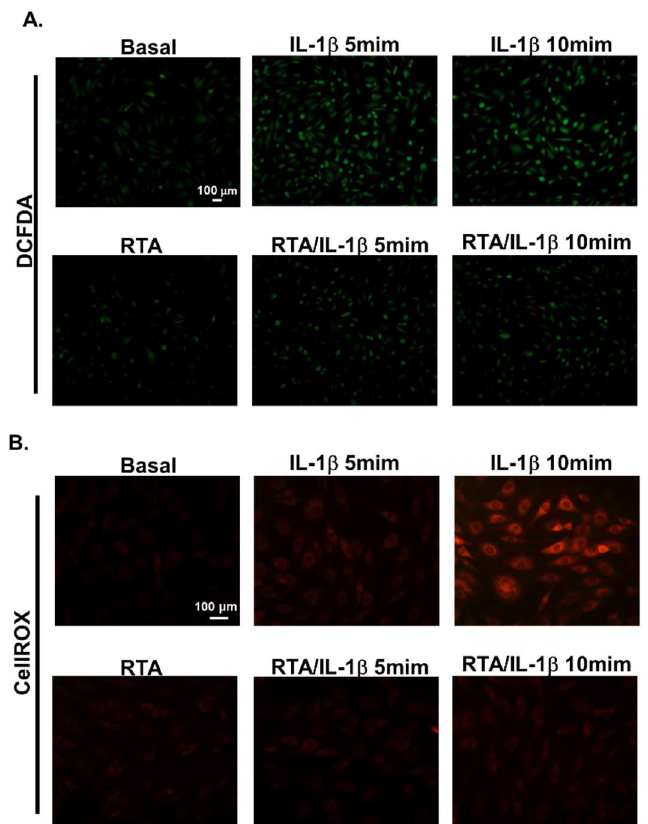
Figure 3. Reactive oxygen species (ROS) involved in the inhibited mechanisms of RTA 408 on the IL-1 β response in RBA-1 cells. Cells on the coverslips were pretreated with / without RTA 408 (0.3 µ M) for 4 h, and then incubated with IL-1 β (0.5 ng / mL) for the indicated time intervals (5 and 10 min). Then, cells were incubated with 10 µ M DCFH-DA ( A ) and 5 µ M CellROX Deep Red Reagent ( B ) for 30 min, respectively, the fluorescence intensity was detected under a fluorescence microscope. The figure represents one of three individual experiments.